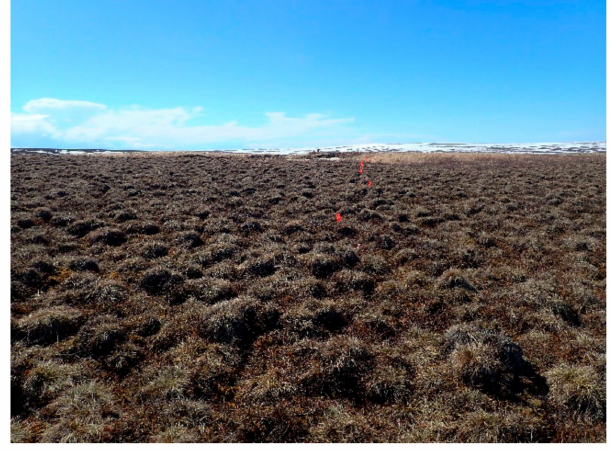
Figure A1. Field photo of SG from SG_T3_90 on 4 June 2018.